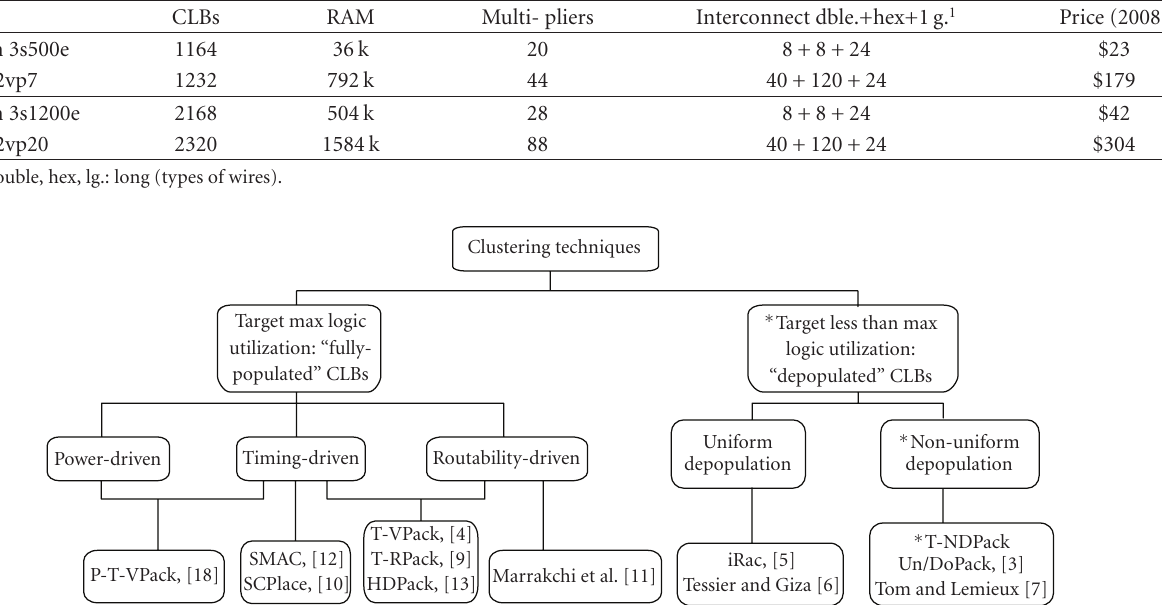
Figure 1: Categorization of clustering techniques based on logic utilization approach and optimization goals. ∗ represents the category of our technique